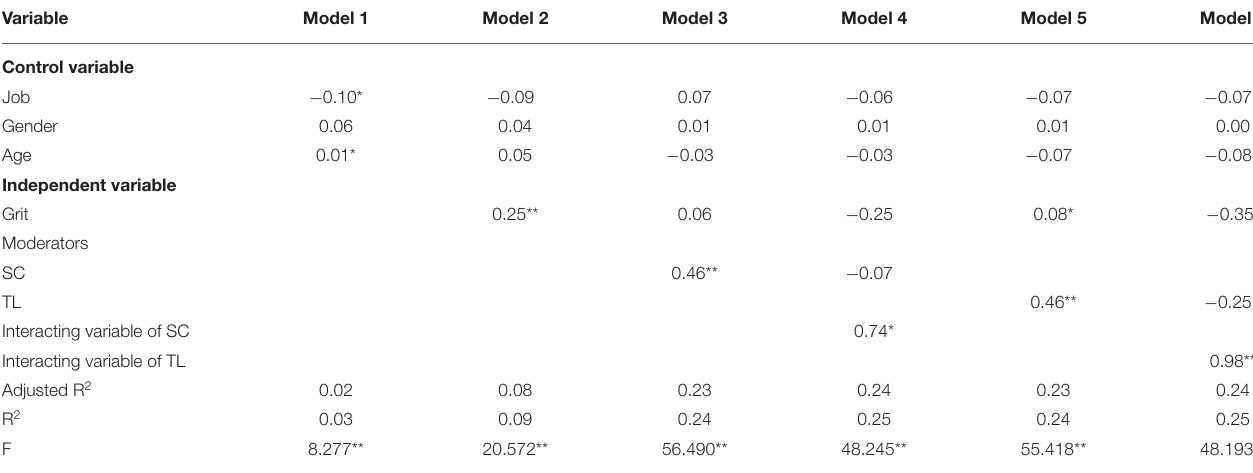
TABLE 3 | A regression-based path analysis for the moderation model of supportive climate (SC) and transformational leadership (TL).